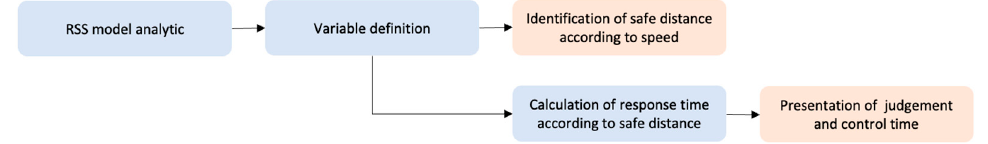
Figure 1. Procedure of this study.